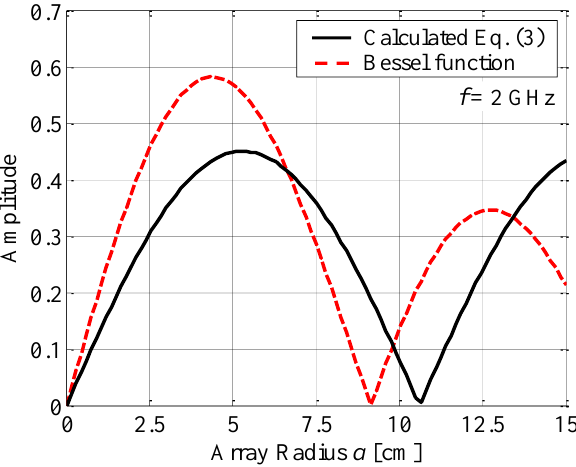
Figure 3. Summation of the whole voltage induced on the four elements. Figure 4 shows the estimated angle φ m defined by Equation (5) as a function of the actual azimuth angle φ with the array radius as a parameter. It can be seen from Figure 4 that the estimated angle is approximately proportional to the actual azimuth angle. However, the error of the estimation angle of the incoming wave increases with increasing array radius, indicating a tradeoff relationship between the radiation gain and the accuracy of the estimation angle.